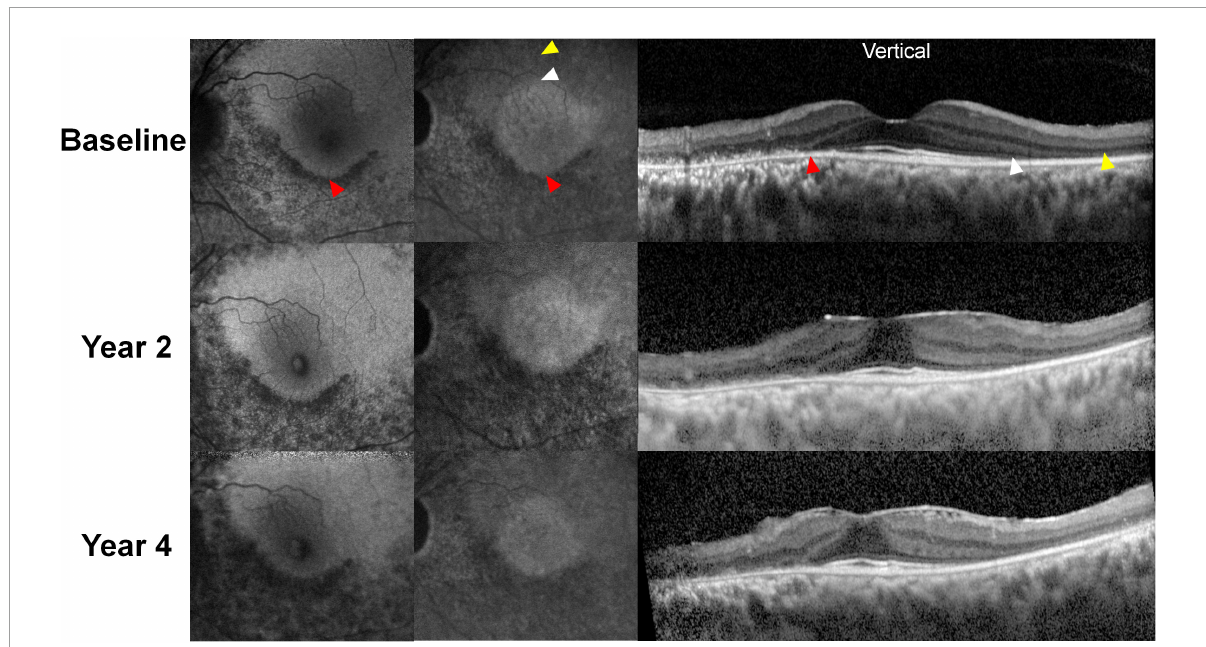
FIGURE6 Representative blue and near-infrared autofluorescence images (BAF and NIA, respectively) and optical coherence tomography B-scan images over the 4-year follow-up period in a patient treated with hydroxychloroquine 300 mg per day for 13 years. Hypoautofluorescence was almost identical on BAF and NIA images, which correspond to the defective (thinned) retinal pigment epithelium/Bruch’s membrane complex line. However, NIA demonstrates a central hyperautofluorescent area, aligns to the area with intact photoreceptor layers (borders between the areas with and without photoreceptor defects demarcated by white arrowheads). In contrast, BAF showed no clear distinction between the areas with and without photoreceptor defects in the superior (S) parafoveal area. As the areas with intact photoreceptors decreased over time due to progression of retinopathy, the central hyperautofluorescence on NIA imaging decreased in size, whereas the superior parafoveal area in BAF shows no definite